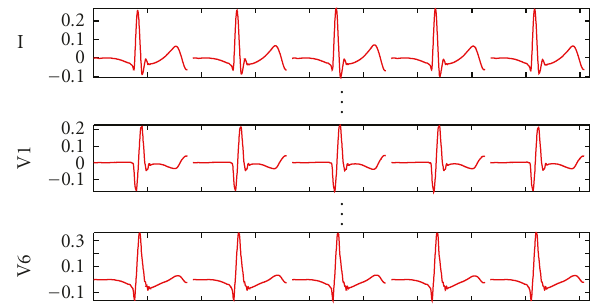
Figure 8: Example of a patient with sinus rhythm: reconstructed ECG channels (ECGR).